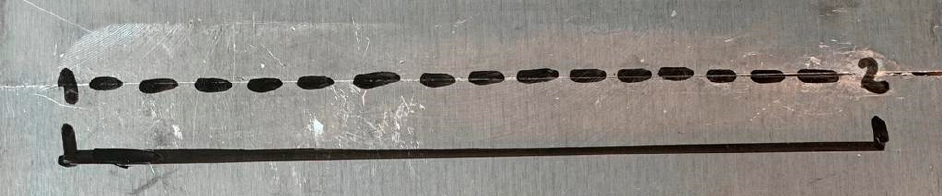
Figure 16. Cavity location for Tool 2 trial, according to ultrasound results (EPOCH 4 ultrasound